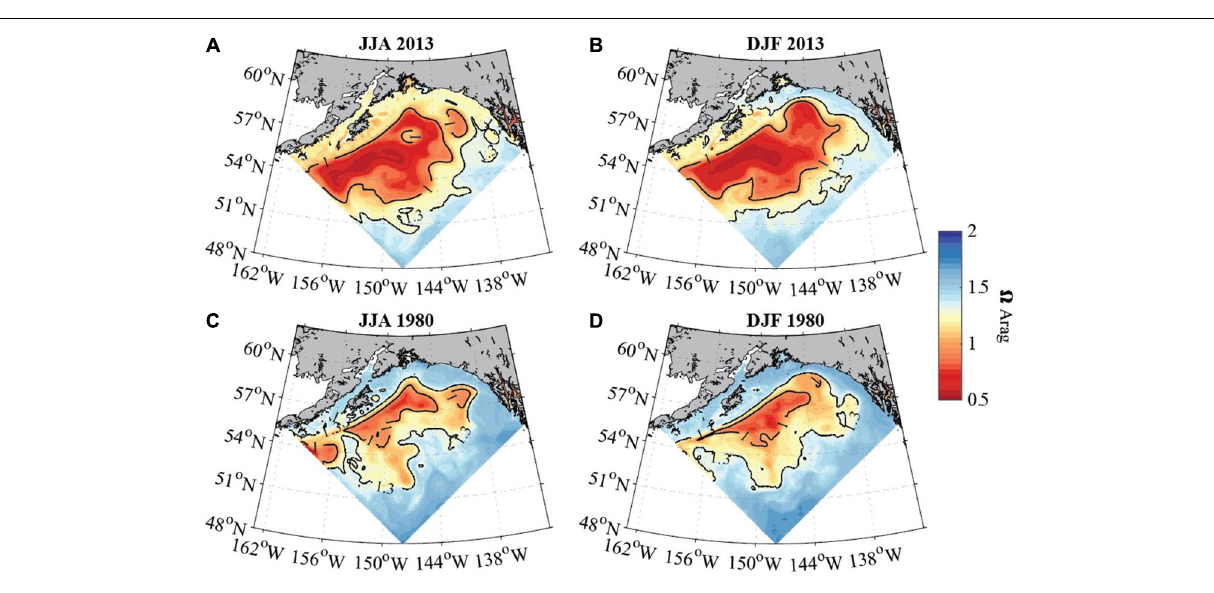
relatively small region of buffered waters within Bristol Bay. The most corrosive waters are located in the northwestern Bering Sea. Panels A and B in Figure 8 illustrate a depth profile of model